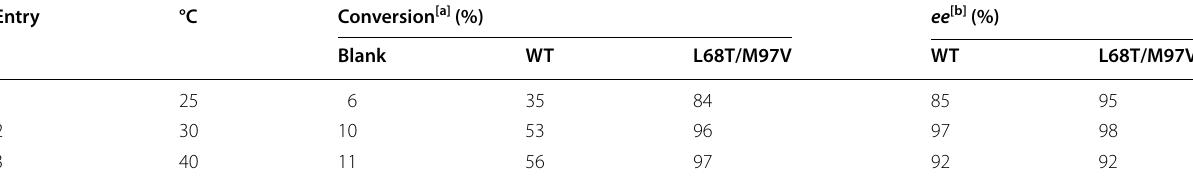
Table 1 Asymmetric synthesis of THIQAs at different temperatures with benzaldehyde and dopamine as